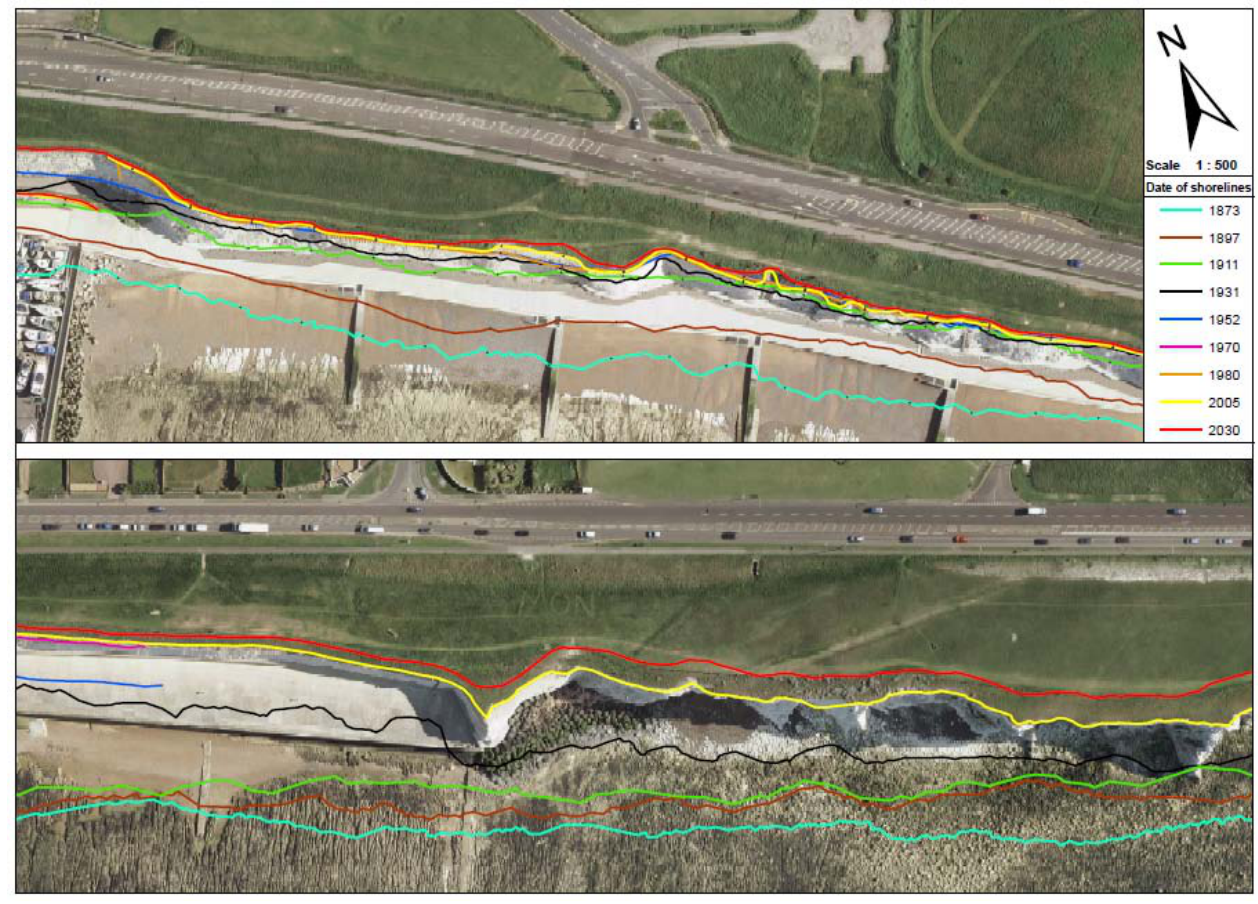
Fig. 8. Visual representations of future shoreline